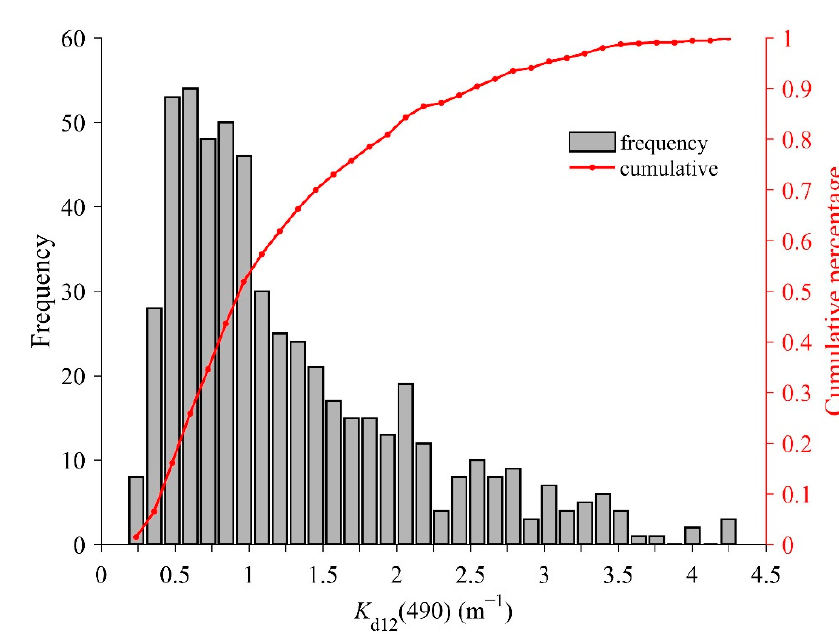
Figure 5. Histogram and cumulative percentage for buoy-measured K d12 ( 490 ) .